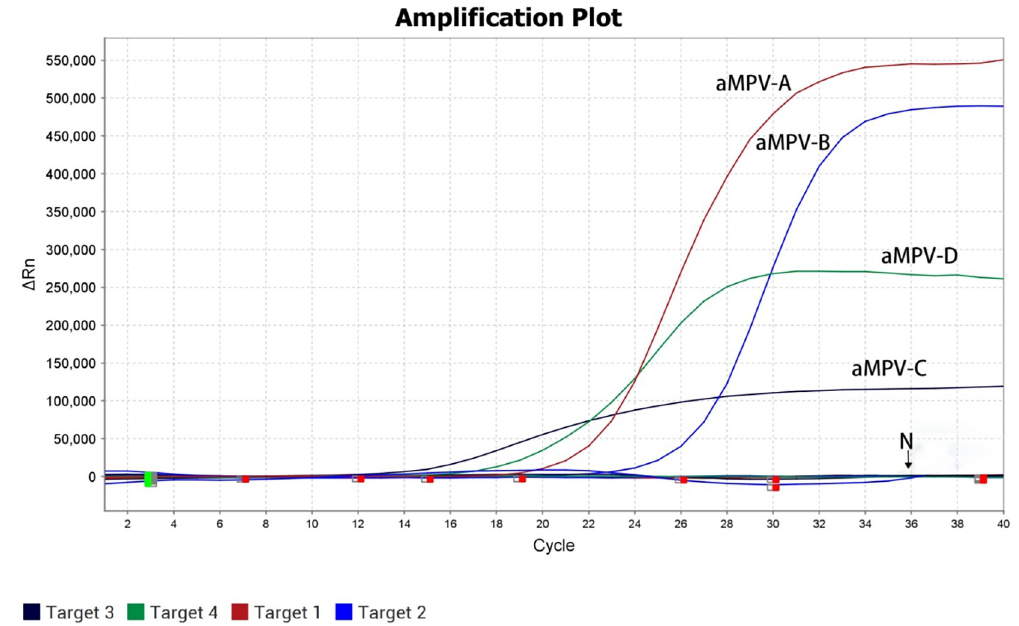
Fig 2. Specificity test results of the quadruple real-time RT-PCR diagnostic method for aMPV.